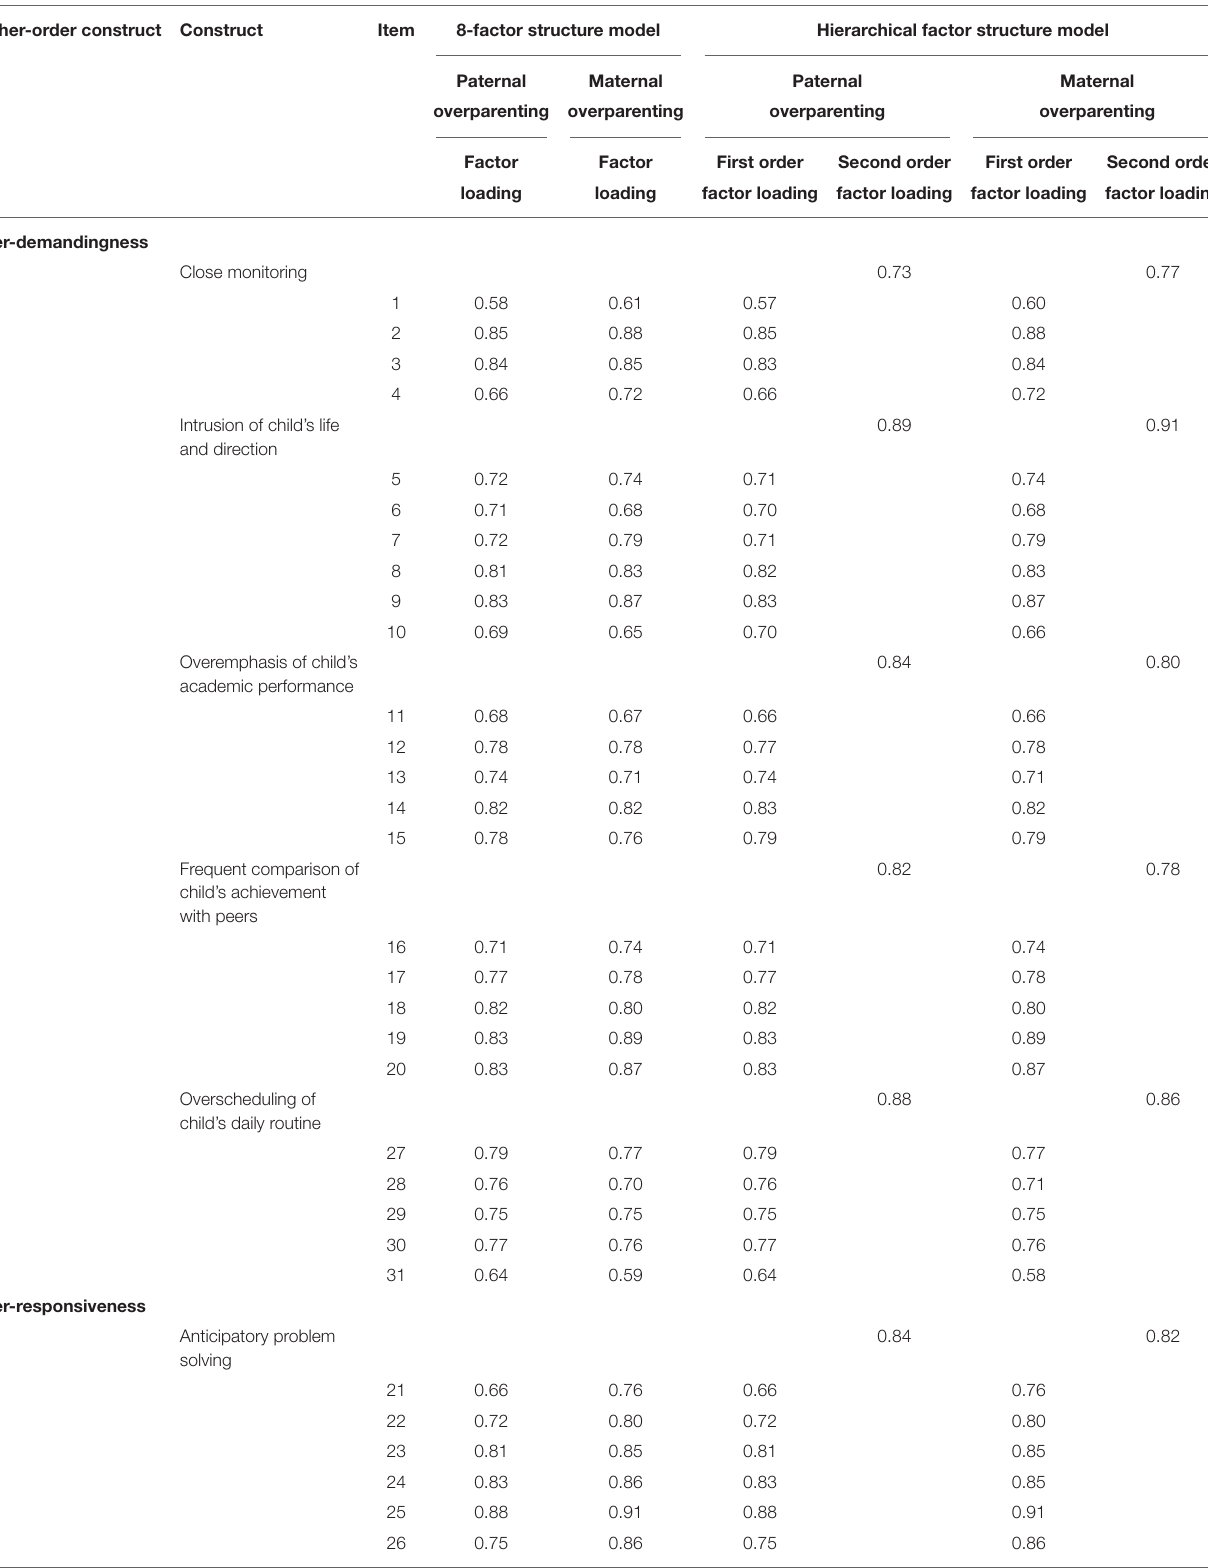
TABLE 6 | Standardized factor loadings of 8-factor structure model and hierarchical factor models of Chinese paternal/maternal overparenting scales. Higher-order construct Construct Item 8-factor structure model Hierarchical factor structure model Paternal Maternal Paternal Maternal overparenting overparenting overparenting overparenting Factor Factor First order Second order First order Second order loading